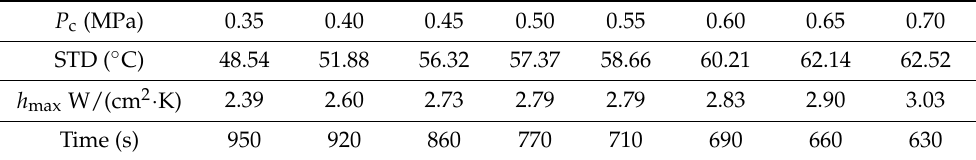
Table 3. Performance parameters in dynamic dissipating